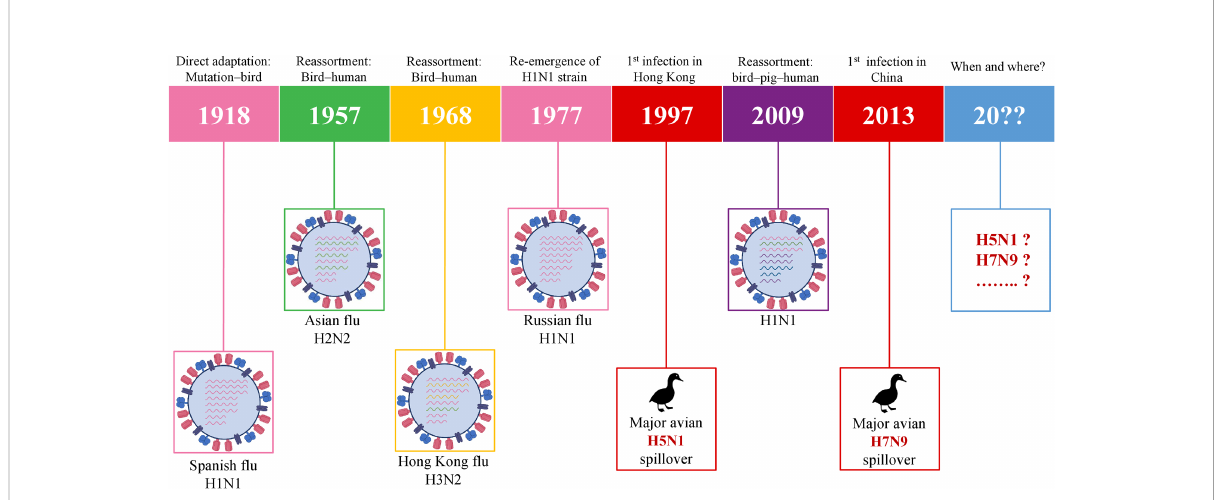
FIGURE 3 Schematic illustration of pandemic IAVs and IAVs with the pandemic potential. IAV, in fl uenza A